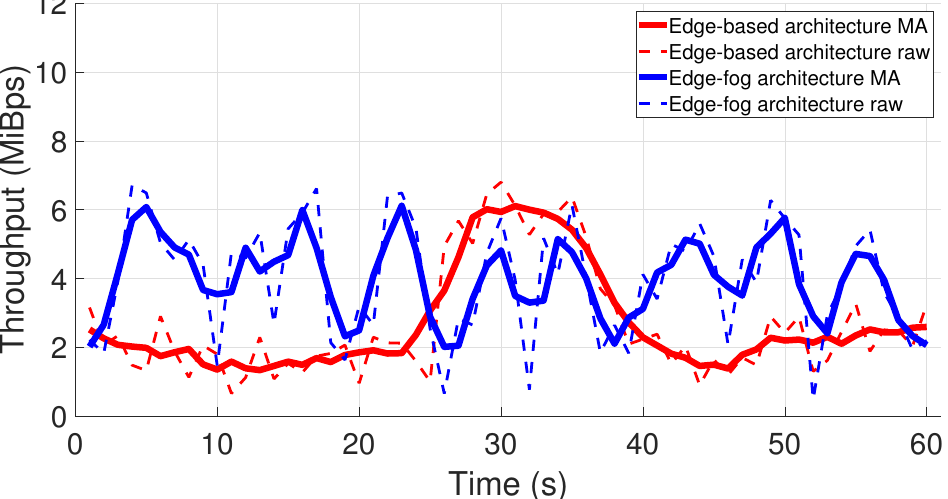
Figure 5. Throughput for both architectures during one minute of scanning. Dashed lines represent raw data, and solid lines represent the moving average.